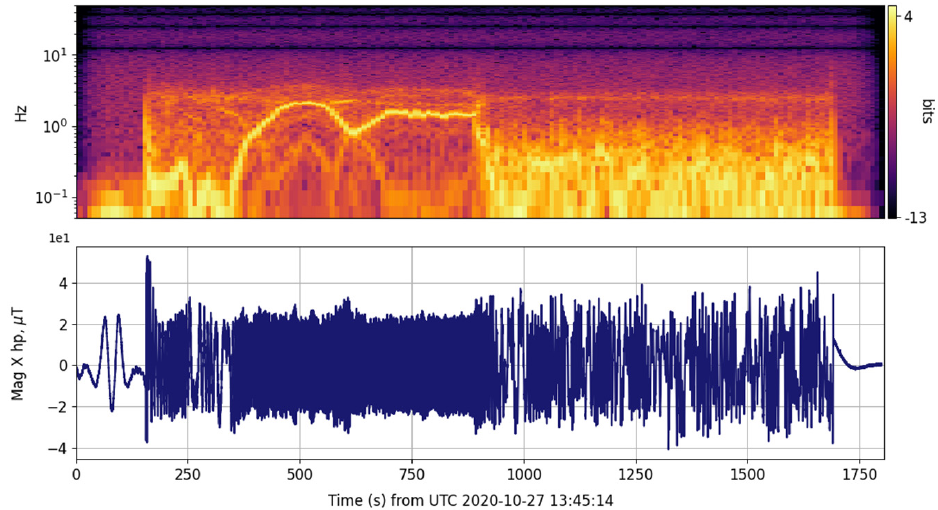
Figure 19. Short-term Fourier transforms of high-pass filtered (hp) waveforms for the X component of the magnetometer (Mag); the Y component is nearly identical.